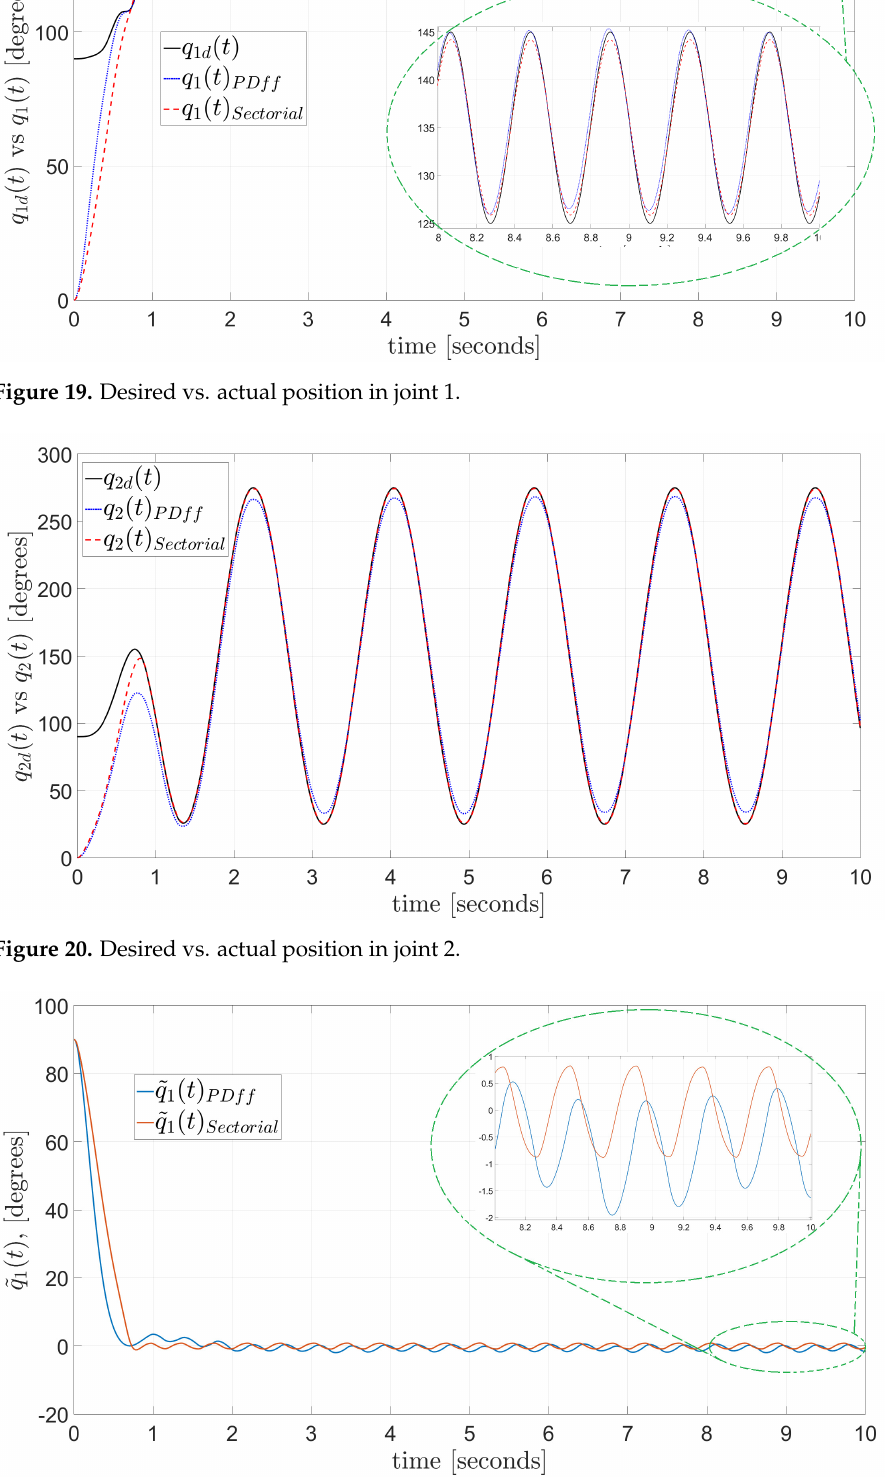
Figure 21. Angular position error in joint